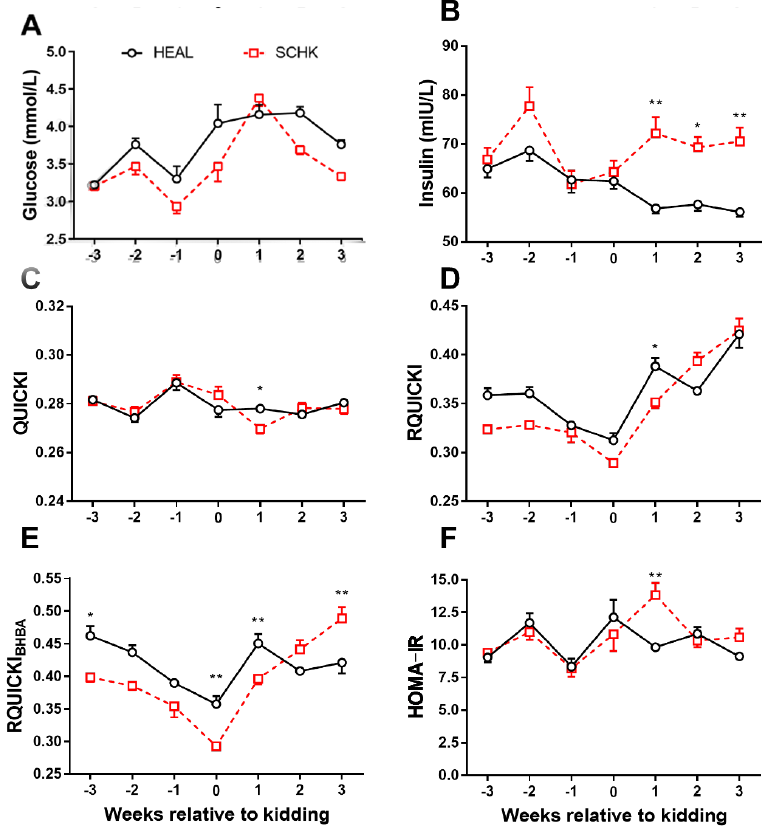
Figure 2. Changes in the concentrations of glucose ( A ), insulin ( B ), QUICKI ( C ), RQUICKI ( D ), RQUICKI BHBA ( E ), and HOMA-IR ( F ) in goats with SCHK and HEAL goats during the peripartum period. * p < 0.05, ** p < 0.01. Values are presented as means ± SEM from 10 goats per group ( n =